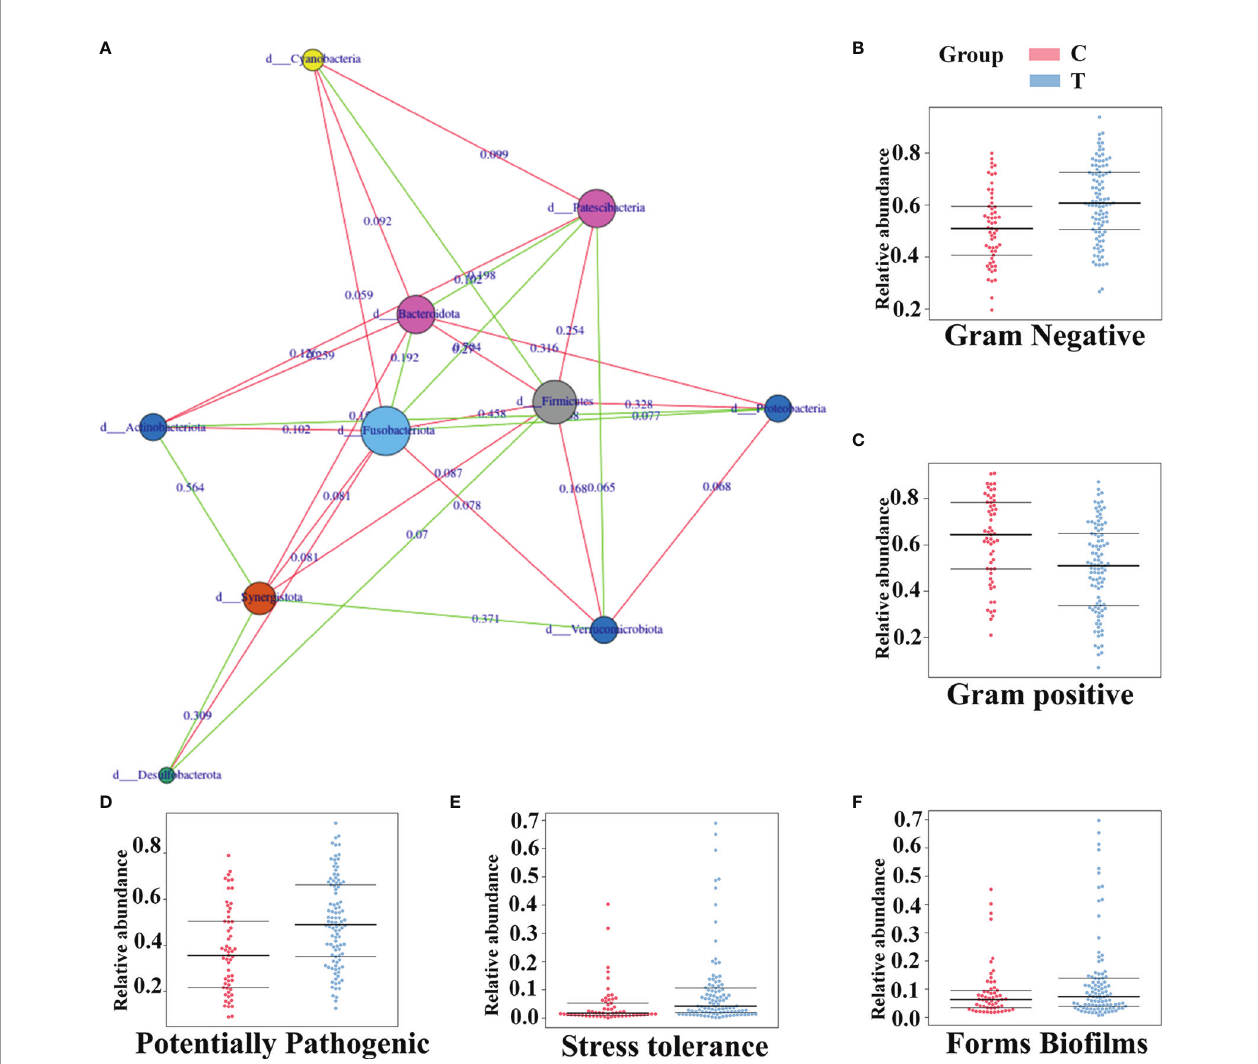
FIGURE 6 | The phenotypic characteristics of gut microbiota and the connection among them in brain tumor patients. The connection among different gut microbiota at the phylum level of brain tumor patients (A) Green represents positive correlation and red shows the negative. And the value on the line represents the association strength. The software of Bugbase was used to predict the phenotypic characteristics of the intestinal fl ora about Gram Negative (B) Gram positive (C) Potentially Pathogenic (D) Stress tolerance (E) Forms Bio fi lms (F) Each spot is a sample.